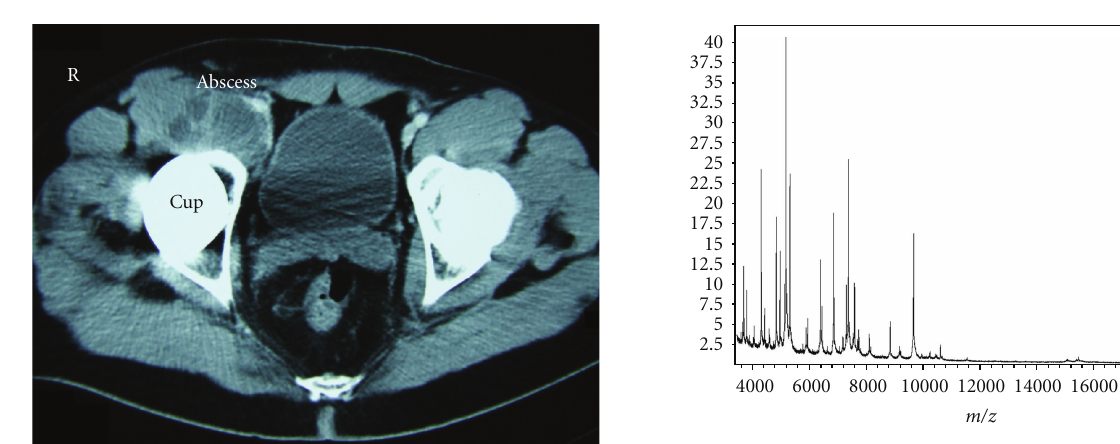
Figure 1: Abscess in front of the hip arthroplasty due to S. lugdunensis. The computer tomography (CT) shows a large cystic formation ventral to the hip reaching the psoas-muscle.